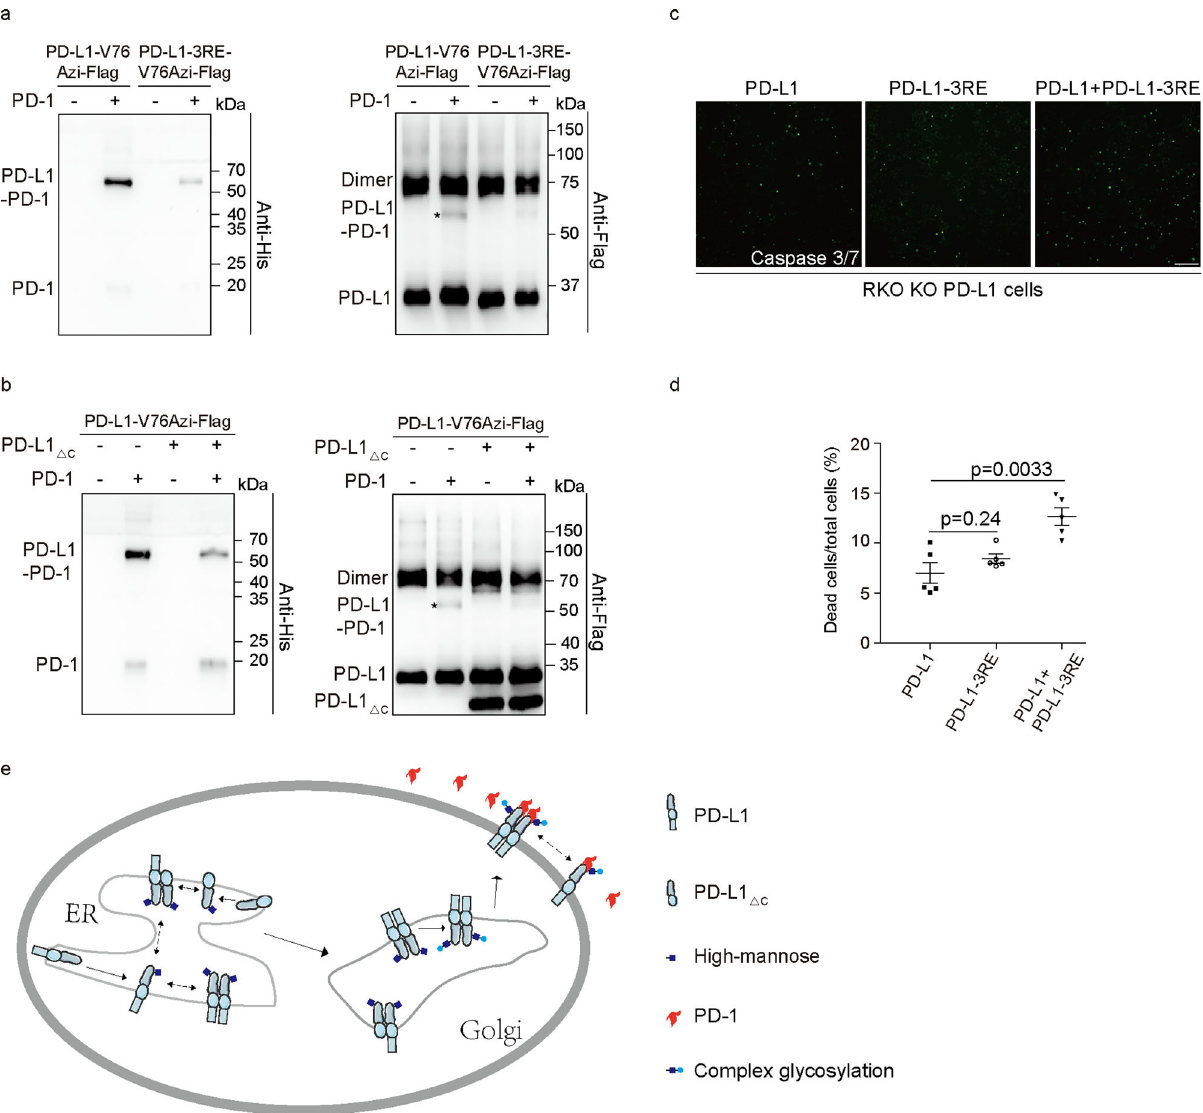
Fig. 7 PD-L1 homodimerization plays an important role in PD-1 binding and T-cell toxicity. a PD-L1-Azi interaction with PD-1 was suppressed by 3RE mutation. Azi was incorporated at V76 of WT PD-L1 or PD-L1-3RE mutant. HEK293T cells were irradiated with UV in the absence or presence of PD-1-His protein. Shown are immunoblotting using anti-Flag and anti-His antibodies. b PD-L1 △ C suppressed WT PD-L1 cross-linking with PD-1. Cells expressing PD- L1-V76Azi-Flag or coexpressing PD-L1-V76Azi-Flag and PD-L1 △ C -Flag were incubated with PD-1-His protein. Covalent cross-linking was induced by UV treatment for 20 min. c , d T-cell mediated tumor cell killing assay in RKO KO PD-L1 cells expressing PD-L1 and PD-L1-3RE. Green fl uorescent was counted as dead cells. Representative phases are shown. Scale bar, 100 μ m. d The ratio of dead cells was quanti fi ed. N = 5. e Schematic diagram of PD-L1 homodimer function. All samples were treated with PNGase F to remove the